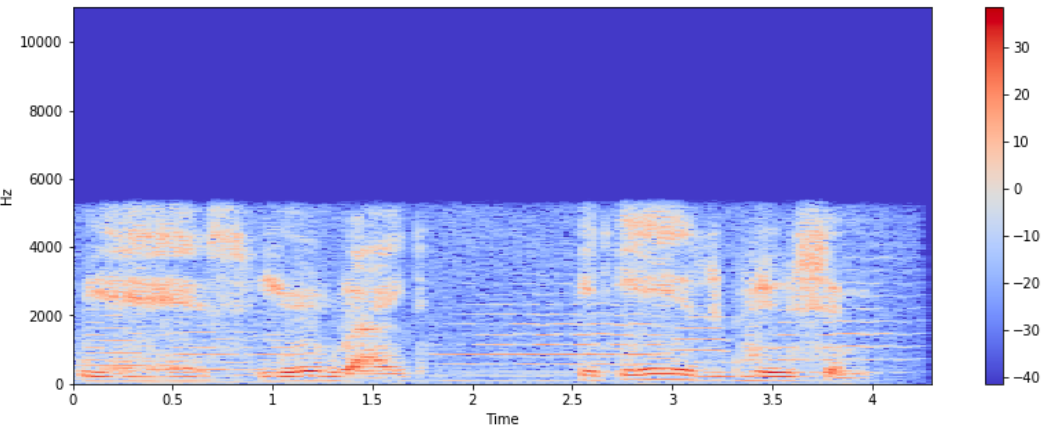
Figure 2. Spectrum of frequencies of signal (Spectrogram).